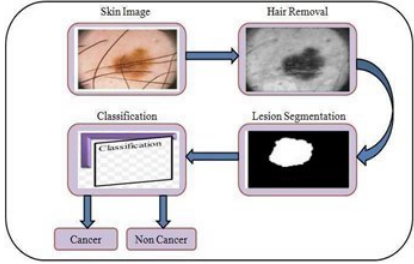
Figure 3.1: Skin Cancer Detection Process